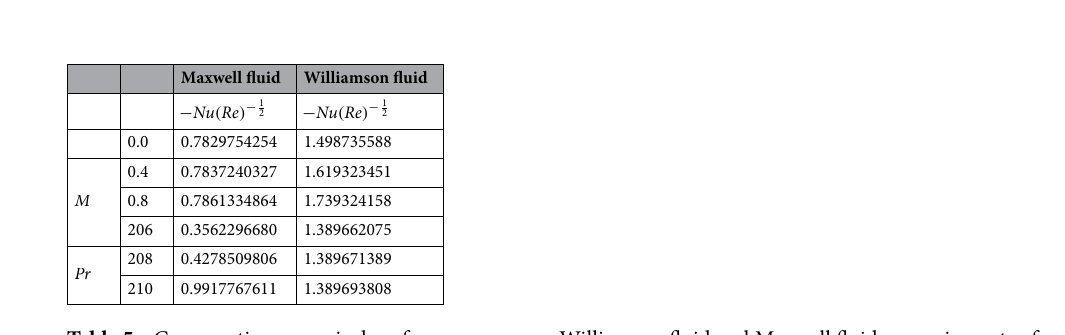
Table 5. Comparative numerical performance among Williamson fluid and Maxwell fluid versus impacts of magnetic parameter and Prandtl